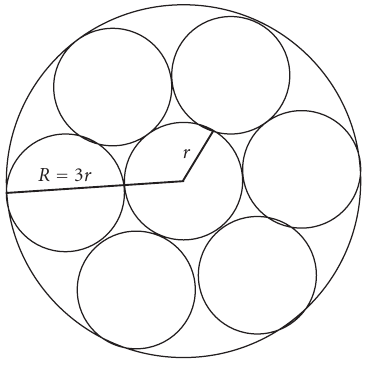
Figure 8: A capillary and interstitial compartmental model [43, 44]. glucose uptake, and di ff usions between capillary and interstitial tis- sues are represented as arrows.